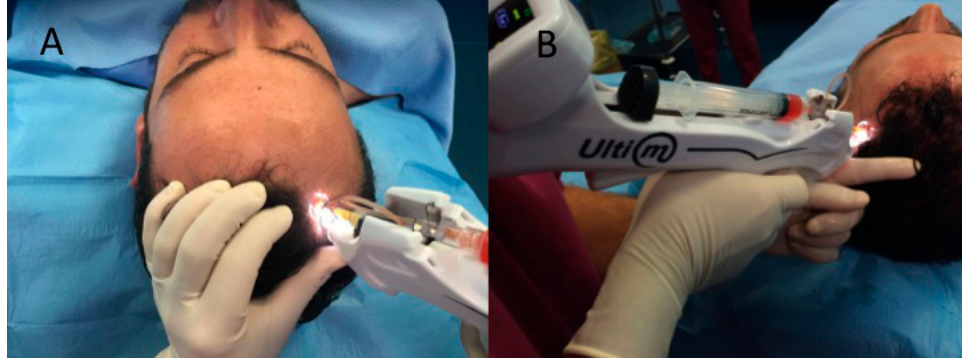
Figure 5. Interfollicular A-PRP injections by Ultim gun (Anti-Aging Medical Systems). ( A ) Interfollicular A-PRP injections (0.2 mL·cm − 2 ) were administered to select areas of the scalp at a depth of 5 mm; ( B ) Ultim gun equipped with a 30-gauge, 10 mL Luer lock syringe in three sessions spaced 30 days apart.